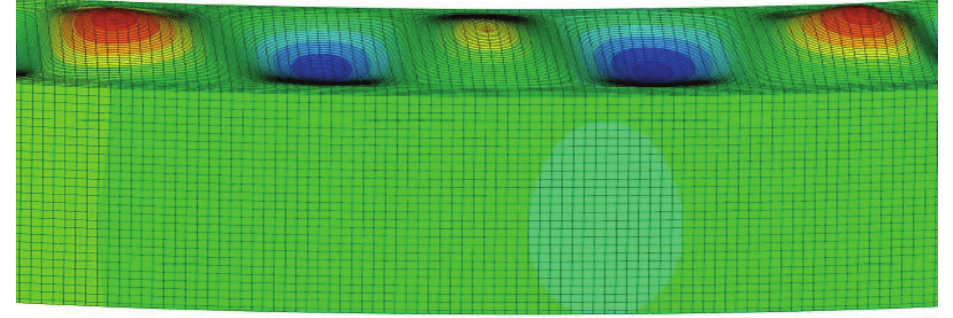
Fig. 7. FEM simulation results for guide at 70% corrosion loss degree. Vertical displacement distribution shows local buckling in the upper mid-section of the guide.